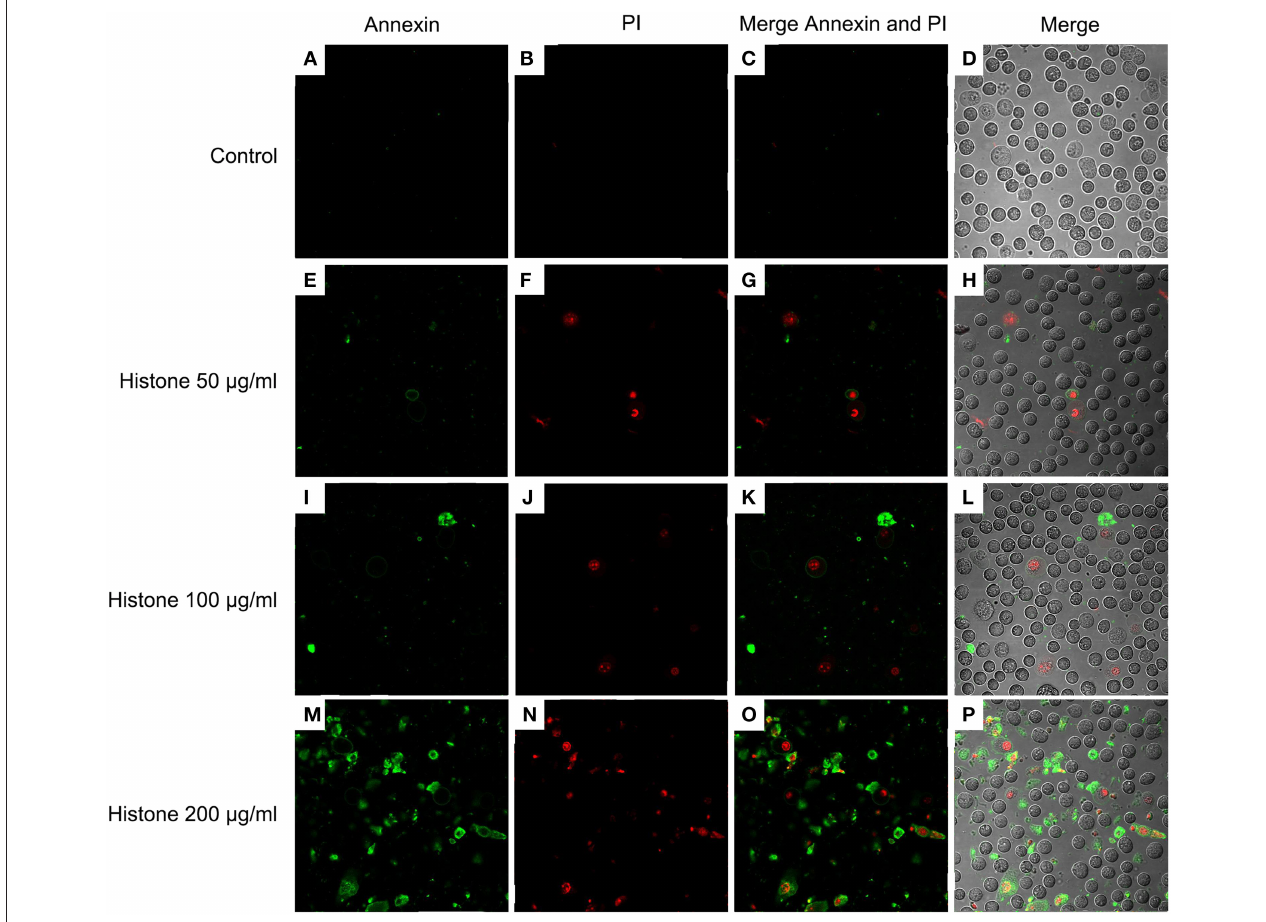
FIGURE 6 | Fluorescence confocal microscopy analyses of histone caused BMECs apoptosis, necrosis, and pyroptosis (400 × ). BMECs were incubated with stimulated histone for 16h. Then, the BMECs were dissociated and stained FLUOS-Annexin V/PI according to the manufacturer’s protocols and were examined by fluorescence confocal microscopy analyses. Three independent experiments were carried out by fluorescence confocal